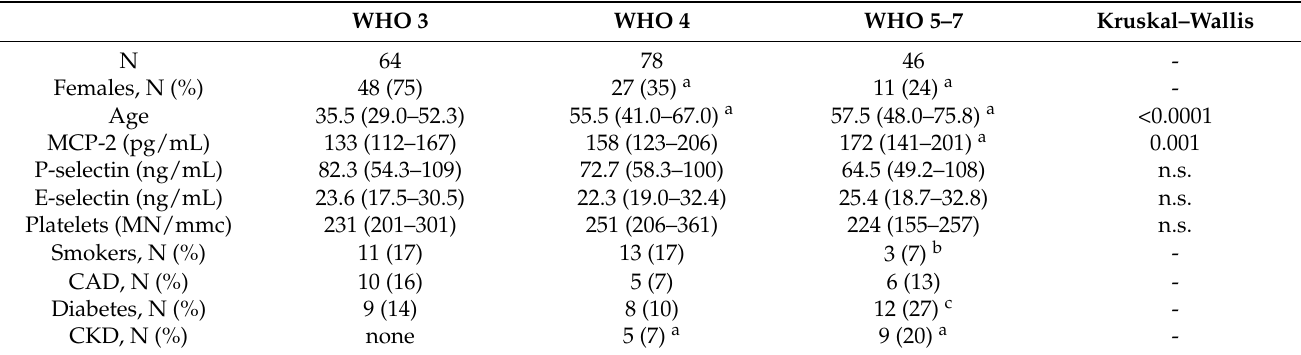
Table 1. Comparison of age, serum MCP-2, selectins, and platelet number in hospitalized COVID-19 patients at admission, subgrouped based on the WHO stage.